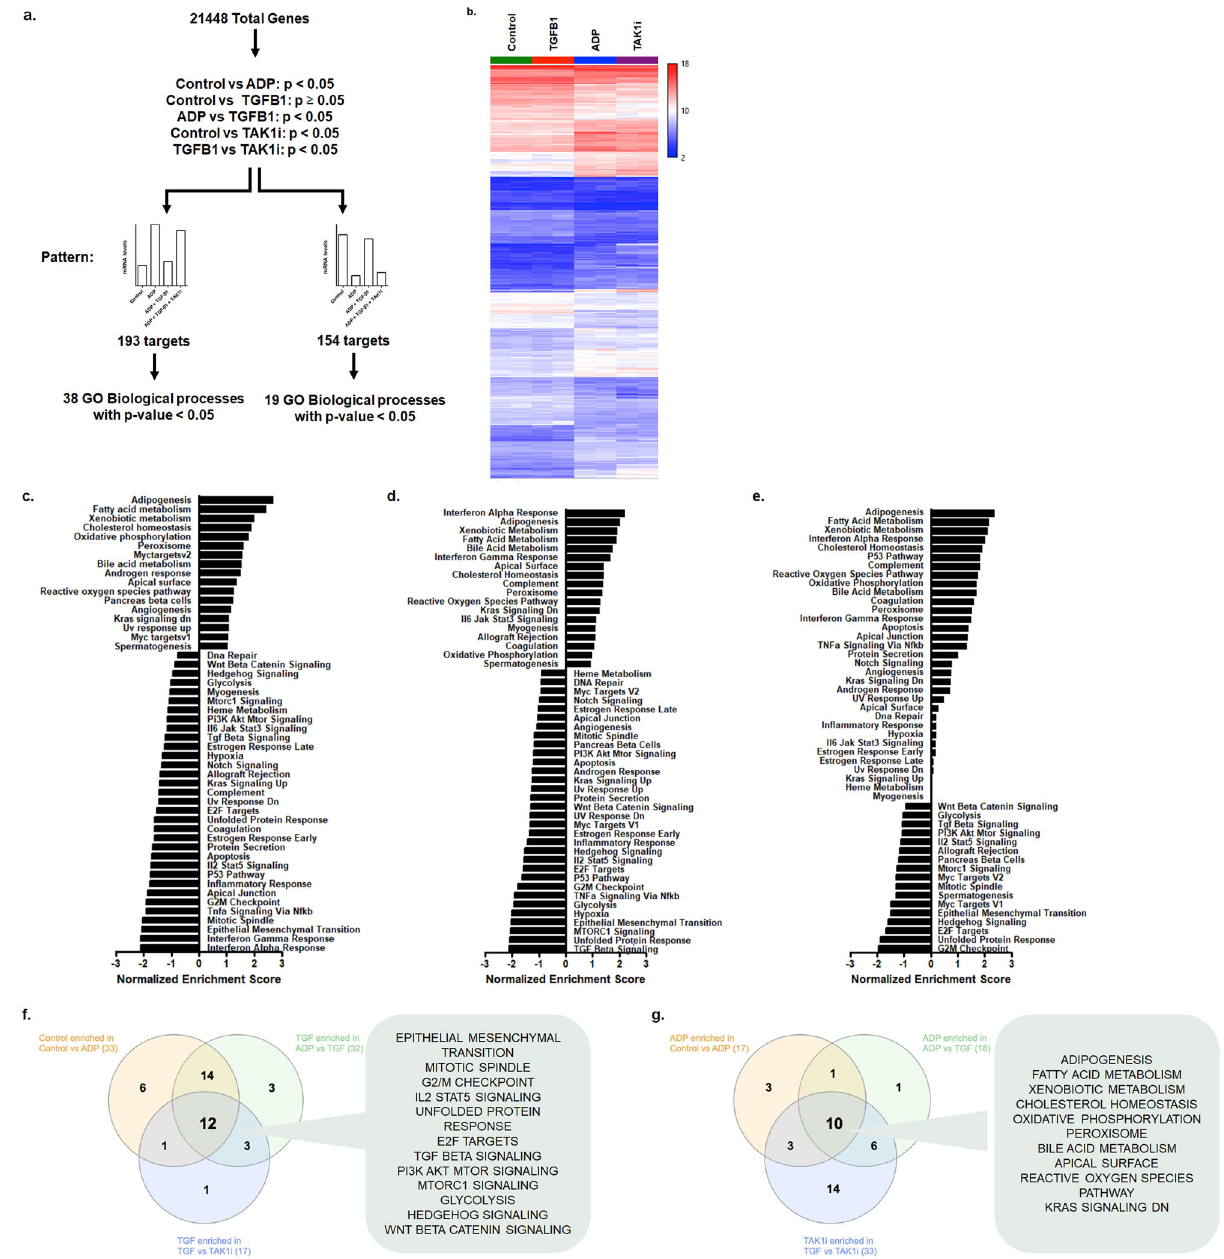
Fig. 7 Identifying TGFB-responsive genes in bone marrow-derived mesenchymal progenitor cells. a A threshold of p = 0.05 was used to identify differentially regulated genes between the groups. The patterns sought, either (1) genes upregulated with adipogenic media with/without TAK1 inhibitor (TAK1i), which is normalized with TGFB1; or (2) genes downregulated with adipogenic media with/without TAK1i, which is normalized with TGFB1. The identi fi ed targets were further analyzed with the DAVID informatics tool to identify signi fi cant biological processes. b A heatmap of the differentially expressed genes (347 genes) from the Clariom S Assay ( n = 2 for each group) that clusters Control and TGFB1; and ADP and TAK1i. The gene set enrichment analysis for groups: c Control versus adipogenic differentiation; d adipogenic differentiation versus adipogenic differentiation with TGFB1; and e adipogenic differentiation with TGFB1 versus adipogenic differentiation with TGFB1 and TAK1 inhibitor. A positive normalized enrichment score indicates gene sets that are enriched in bm-MPCs exposed to adipogenic differentiation media ( c , d ) and adipogenic differentiation media with TGFB1 and TAK1 inhibitor ( e ). A Venn diagram illustrating the enriched pathways found in control and TGFB1 ( f ) and adipogenic differentiation and TAK1 inhibitor ( g ). The list of pathways is the common pathways found in all three